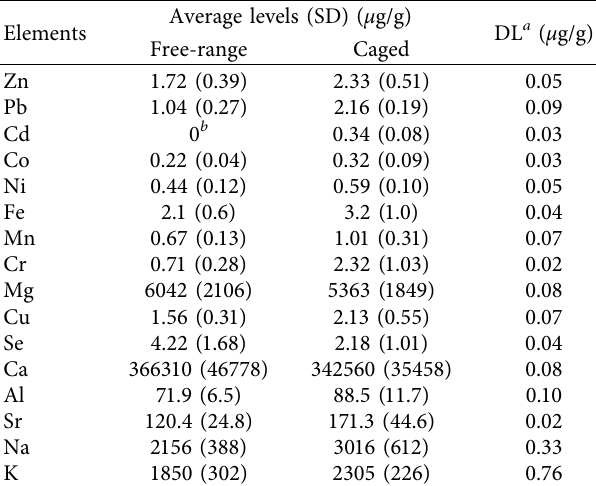
Table 3: Analytical results of 16 elements in free-range and caged